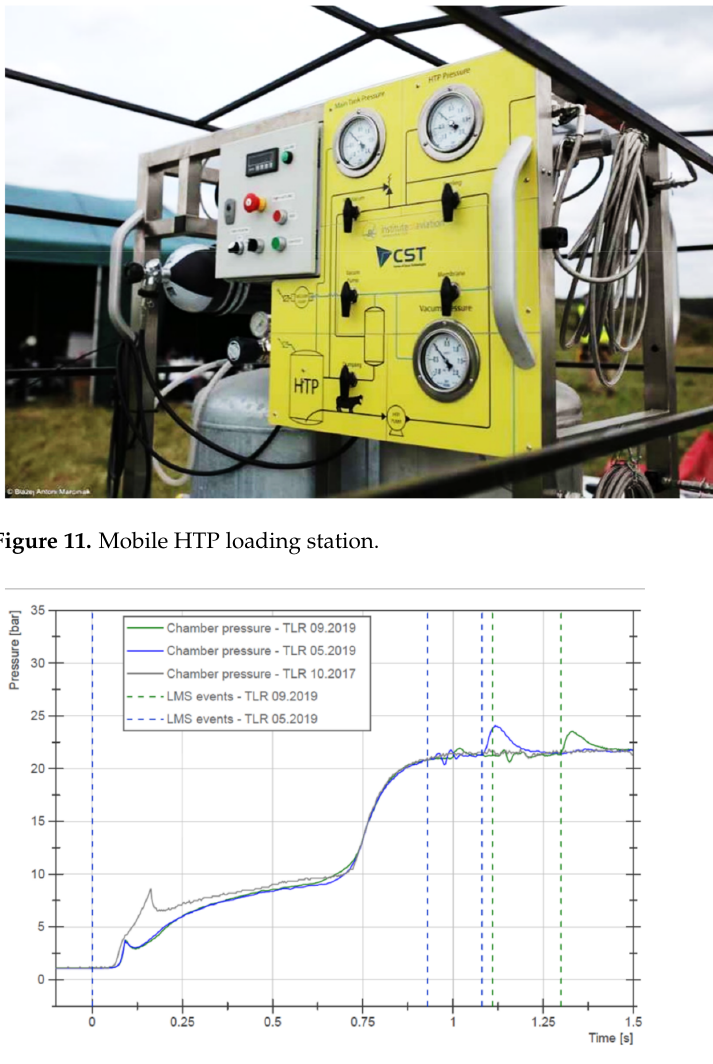
Figure 12. Hybrid rocket motor start-up during 3 in-flight test campaigns.